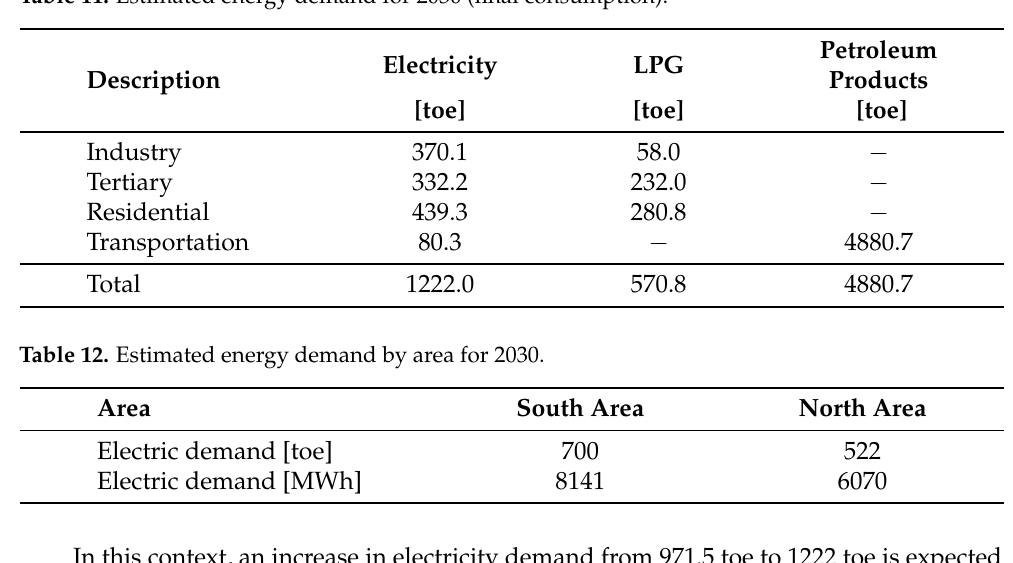
Table 11. Estimated energy demand for 2030 (final consumption).